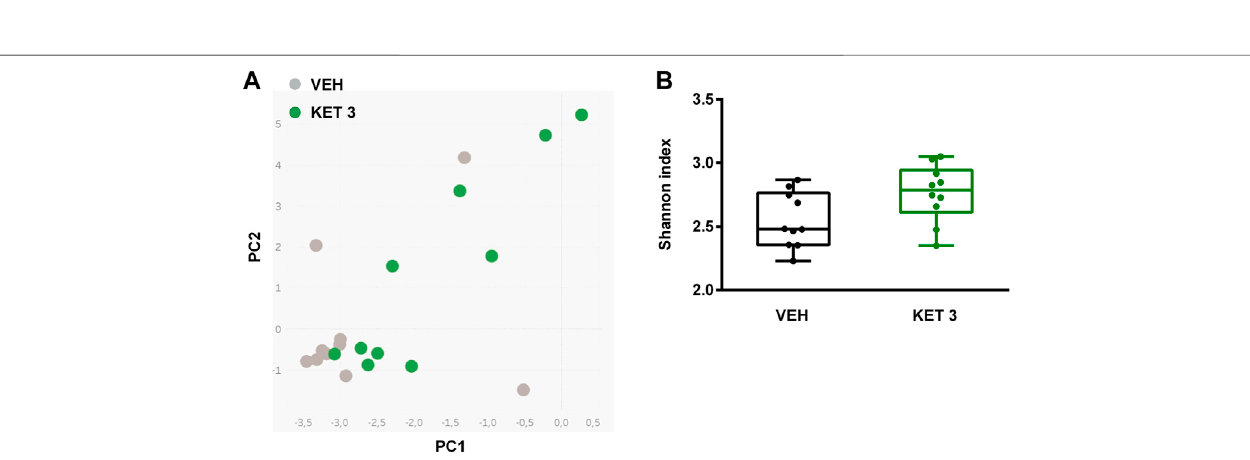
FIGURE5| Panel A :Principalcomponentanalysis(PCA)scoreplotcomparingthesmallintestinalmicrobiotacompositionofratstreatedwitheithervehicle(VEH)or ketorolac (KET, 3 mg/kg) for four weeks. Panel B : The effect of ketorolac on small intestinal bacterial diversity, estimated by the Shannon index. Box and whisker plots indicate the medians, fi rst and third quartiles, and the minimum and maximum values, the points represent individual samples. For statistical analysis Mann-Whitney U test was used, n (cid:2) 10/group.